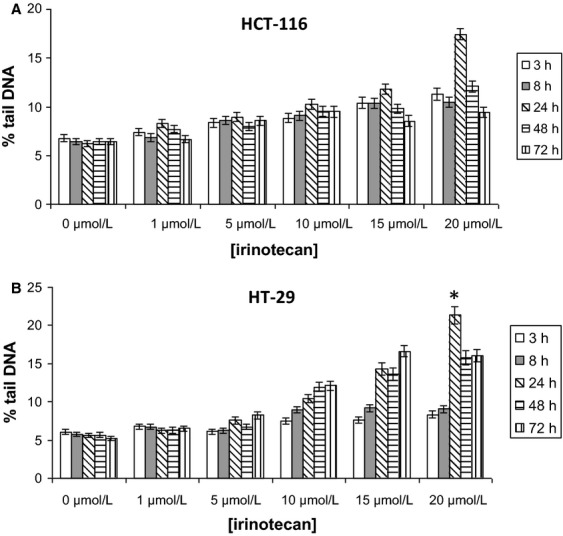
In vitro DNA damage and repair data. (A) HCT-116 and (B) HT-29 irinotecan dose response. Cells were treated with irinotecan doses of 0, 1, 5, 10, 15, and 20 μmol/L for time periods of 3, 8, 24, 48, and 72 h. DNA damage was measured as percentage tail DNA ± SE of the mean of data pooled together from of three independent experiments. *Denotes the HT-29 cells having significantly higher levels of induced damage compared to the HT-116 cells (P = 0.003) following 24-h treatment with 20 μmol/L irinotecan.